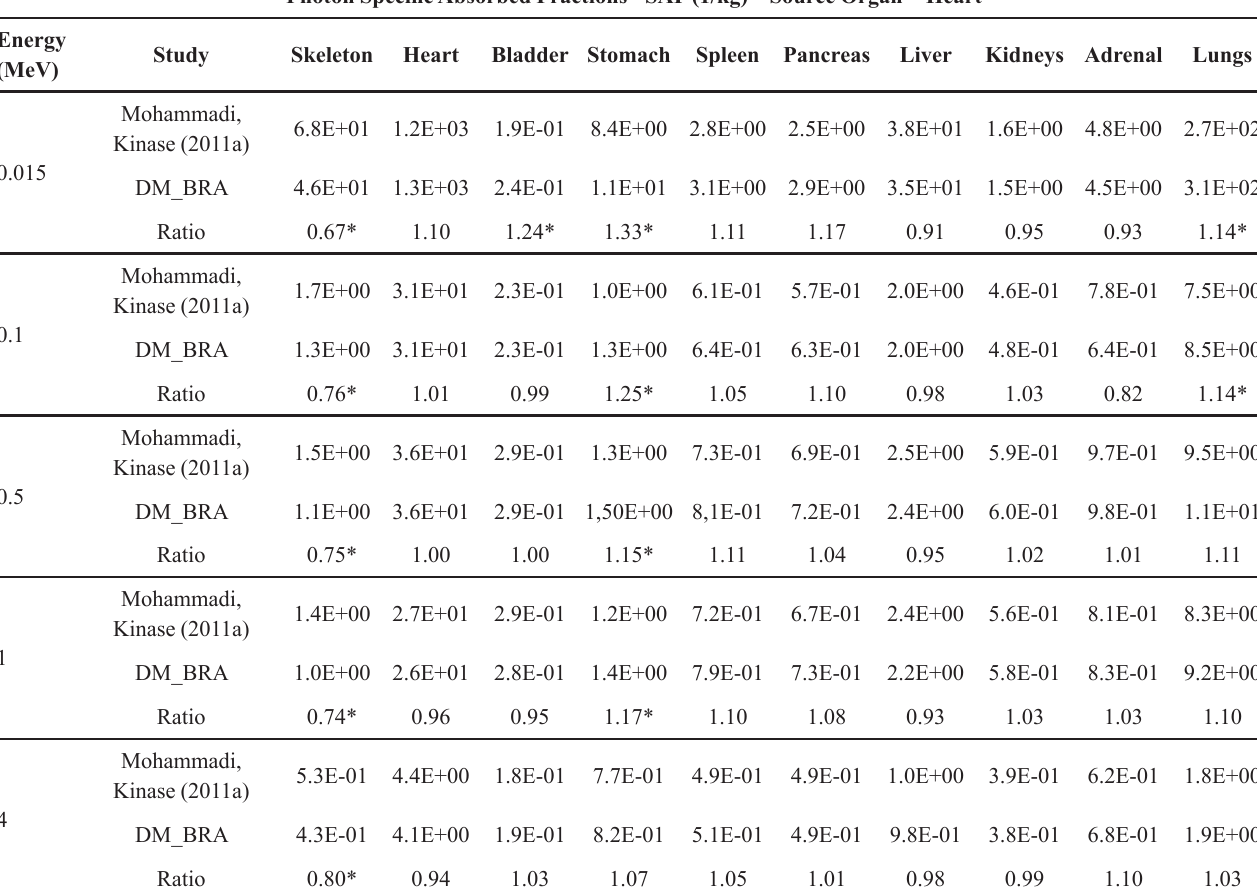
TABLE IV - Specific Absorbed Fraction (SAF) for different organs calculated using MCNPx +F6 tally. Comparison with reference values published by Mohammadi, Kinase